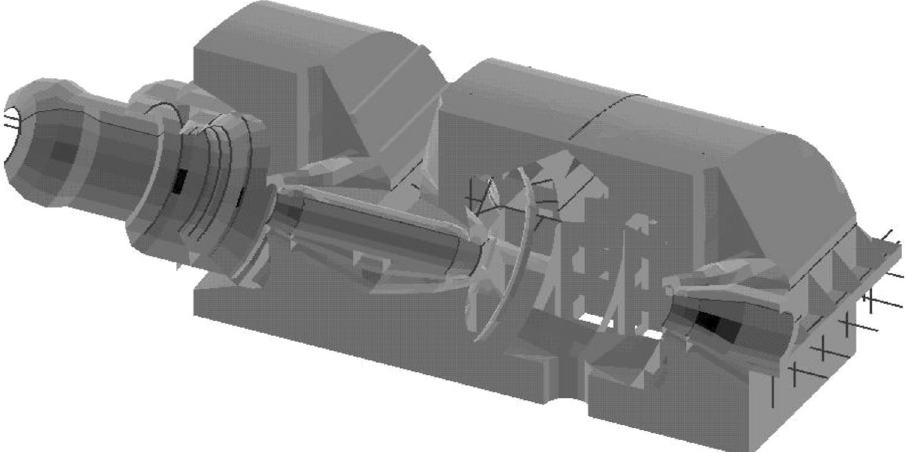
Fig. 6 Geometric simplified model 9